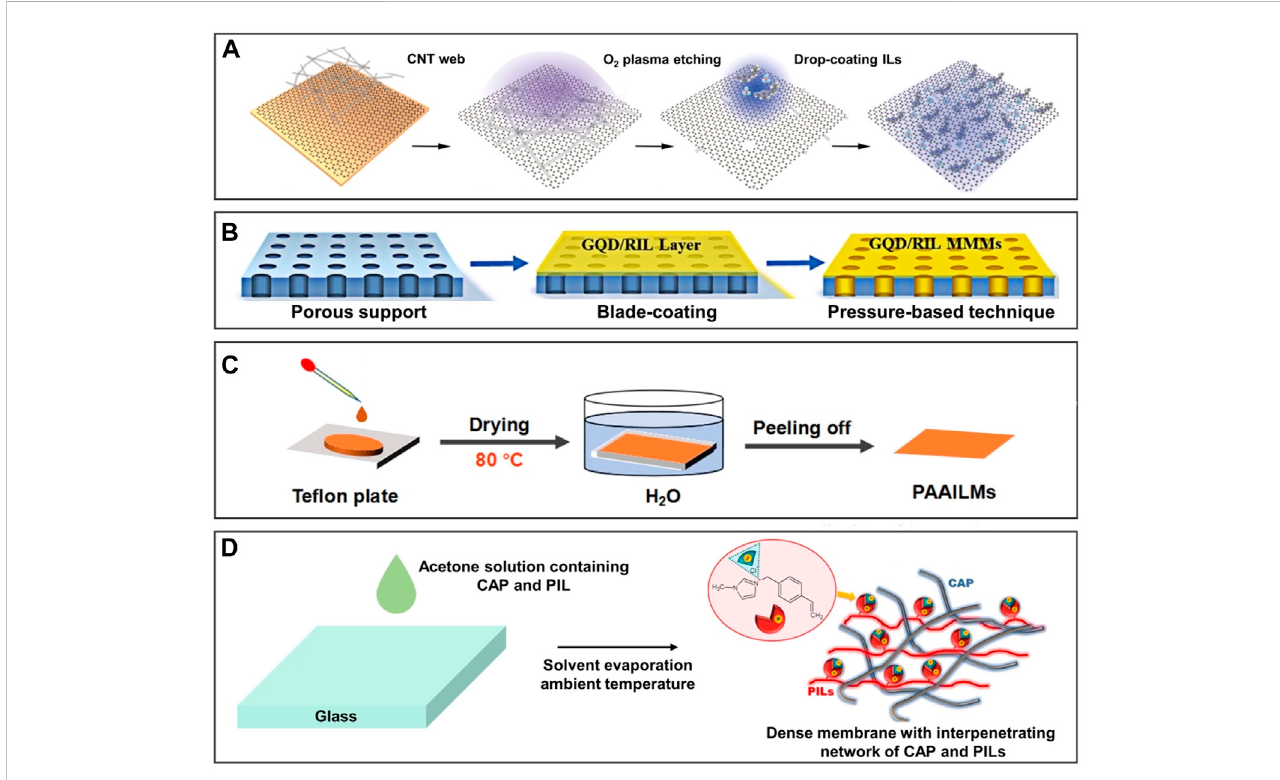
FIGURE 4 Preparation methods of 2DIL-infused membranes. Schematic diagram ofIL polymerbrushes grafted surfaces. (A) Impregnating ILsinto thepores ofthe graphene-based membrane by capillary force for separating CO 2 and N 2 . (B) Impregnating ILs into the membrane by pressure difference and capillary force for separating ethylene/ethane. (C) Reducing the viscosity of PAAILs by heating at 80 ° C to impregnate the PVDF-based membrane for separation of amino acids. (D) Reducing the viscosity of impregnating 1-methyl-3-(4-vinylbenzyl)-1H-imidazol-3-ium chloride by dissolving in solvent to impregnate the membrane based on cellulose acetate propionate for dehydration of propan-2-ol. (A) is reproduced with permission (Guo et al., 2020). Copyright 2020, American Chemical Society; (C) reprinted with permission (Dou et al., 2021). Copyright 2020, Wiley-VCH GmbH; (B) reproduced with permission (Liu L. et al., 2021). Copyright 2021 Elsevier Inc; (D) reproduced with permission (Rynkowska et al., 2017). Copyright 2020, Wiley-VCH